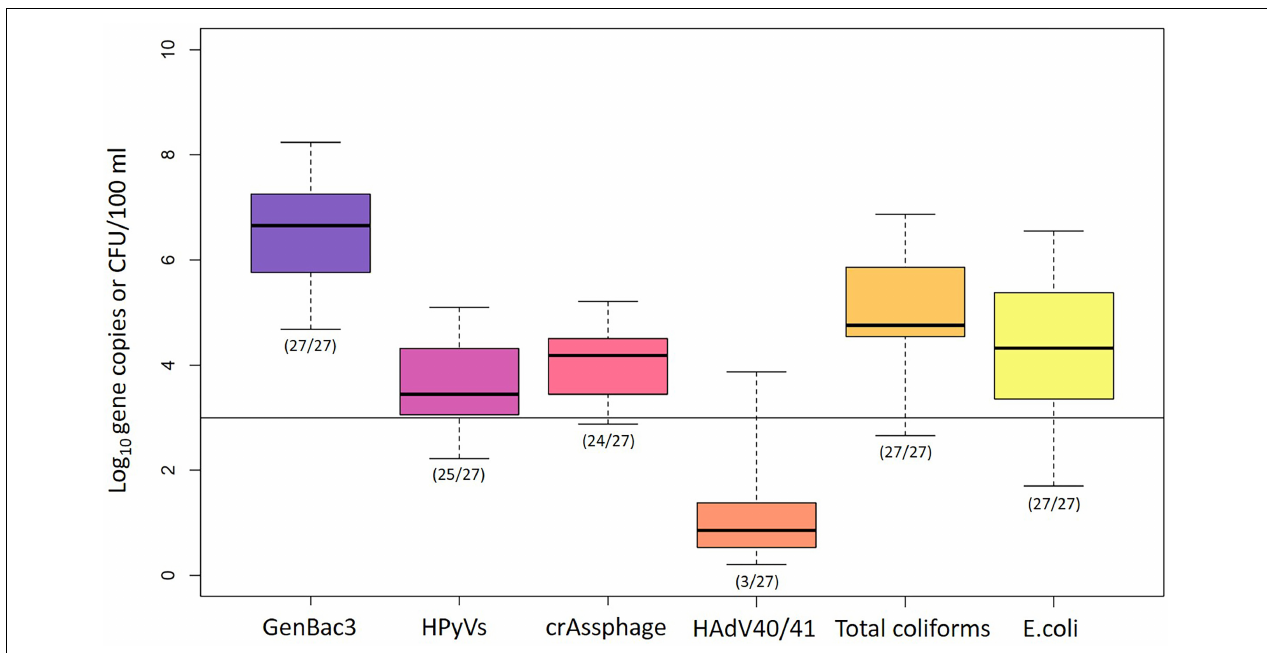
FIGURE 2 | Abundance of microbial water quality parameters. Box plots represent the estimated 25th to 75th percentiles, with the median between. The whiskers exhibit the maximum and minimum values. The numbers in parentheses describe the number of positive samples/the number of total samples. A solid line indicates the highest MLOQ of 3.00 log 10 copies/100